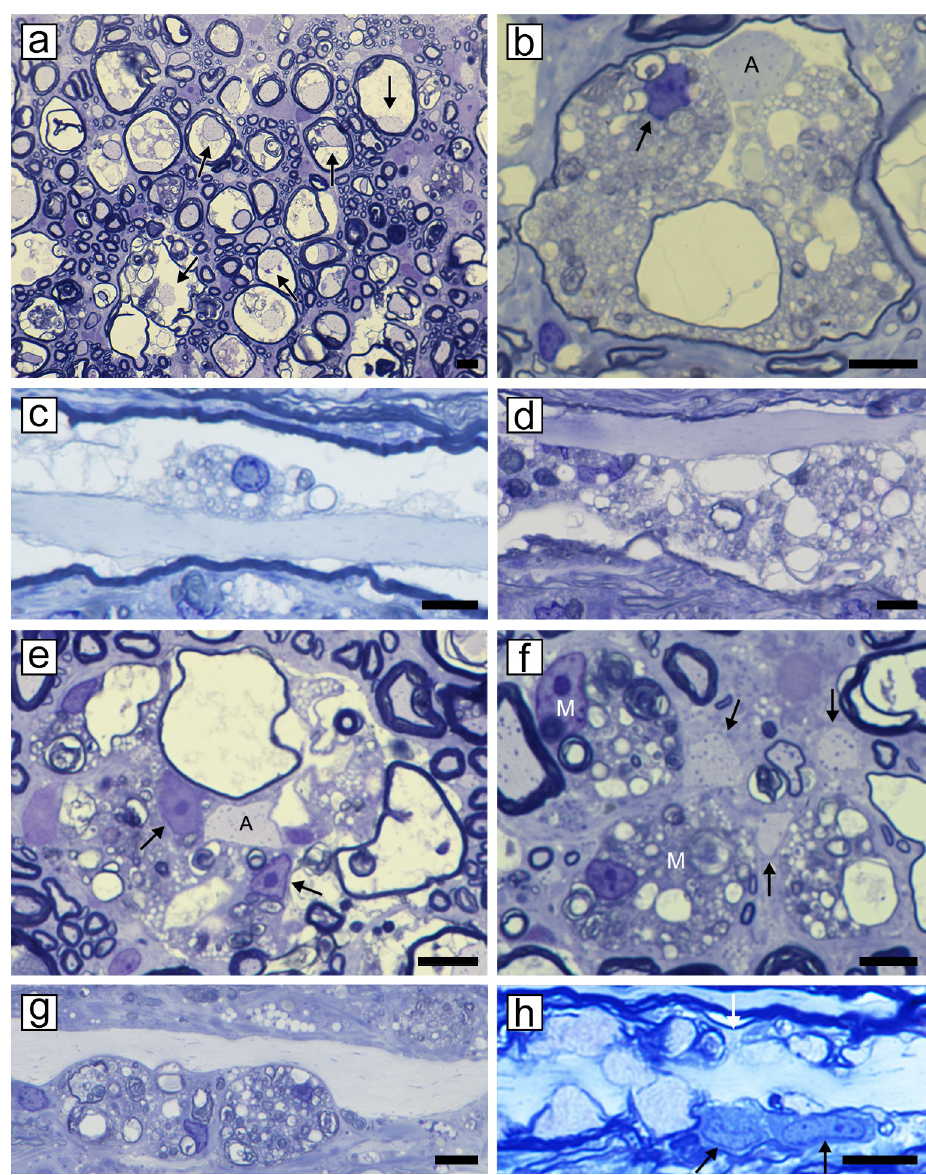
Fig 4. Progressive myelin vacuolation leads to macrophage/microglia infiltration, myelin breakdown and demyelination but with axon preservation. a) The earliest change in white matter is extensive myelin vacuolation but with preservation of axons (arrows). b) Vacuolation leads to myelin breakdown though the outer myelin lamellae remain intact and the axon is preserved (A). A macrophage can be seen in the degenerating myelin (arrow). c,d) On longitudinal sections at this stage, single (c) or multiple macrophages are present in degenerating myelin. e) Eventually the whole myelin sheath degenerates and numerous macrophages are present digesting the cellular debris (arrows) while the axon remains intact (A). f) In the end stage, demyelinated axons are seen lying free in the neuropil (arrows) adjacent to macrophages (M) filled with myelin debris. g) Demyelinated axons may be compressed by abutting debris- filled macrophages. h) Longitudinal sections show cells resembling macrophages (arrows), at a node of Ranvier (white arrows). Scale bar: 20 μ m. the sub-pial surface of the fasciculus gracilis (Fig 8) although on either side, a thin sub-pial rim of remyelinated axons (fasciculus cuneatus) remained. Cells with the ultrastructural appear- ance of mature oligodendrocytes were seen in the core of the fasciculus gracilis, associated